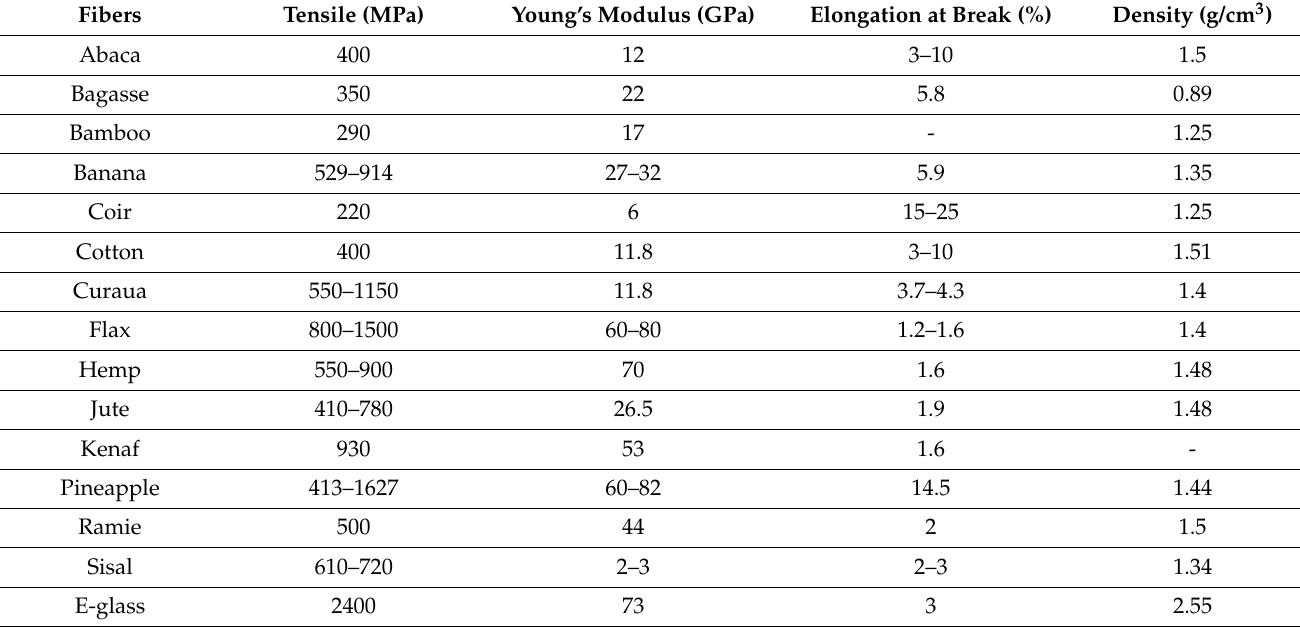
Table 4. Natural and E-glass fibers properties